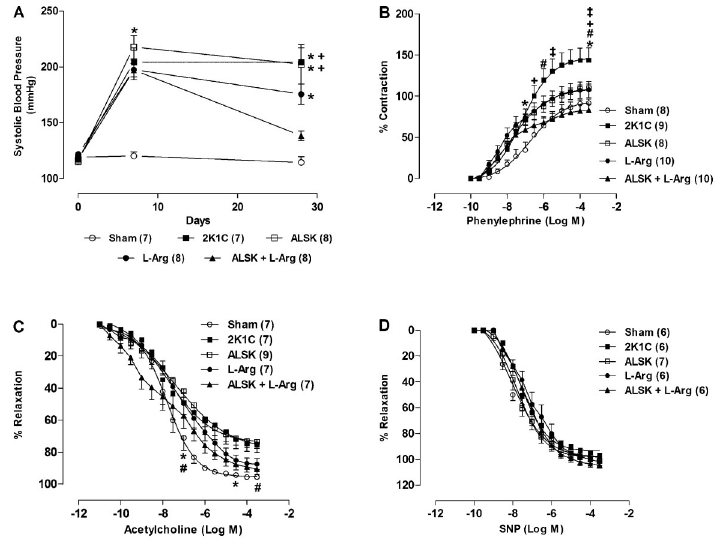
Figure 1. Effects of aliskiren (ALSK), L-arginine (L-arg) and a combination of both on systolic blood pressure throughout the experiment ( A ). Effects of ALSK and L-arg treatment in renovas- cular hypertension on the concentration-response curvestophenylephrine ( B ),acetylcholine( C ) and sodium nitroprusside (SNP) ( D ) in the aortic rings. Data are reported as means±SE. The number of animals in each group is indicated in parentheses. *P , 0.05 vs Sham; # P , 0.05 vs ALSK; { P , 0.05